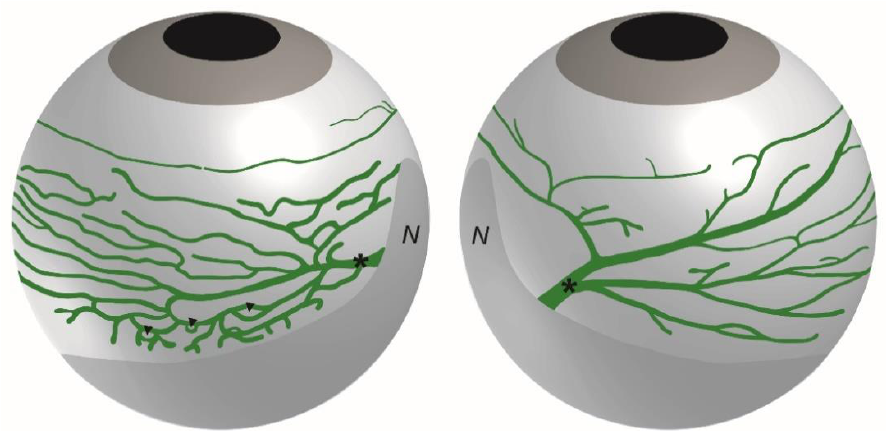
Figure 3. Schematic representation of the lymphatic ocular surface network. The lymphatic network of a right eye on both sides of the nictitating membrane is drawn. The network located at the left side of the nictitating membrane drains the ventral part of the eyeball whereas the network located at the right side of the nictitating membrane drains the dorsal part of the eyeball. The asterisks mark the main draining collecting vessel on each side of the nictitating membrane. Note the typical rich network displaying several loops (arrowheads) at the left side of the nictitating membrane. N, nictitating membrane.